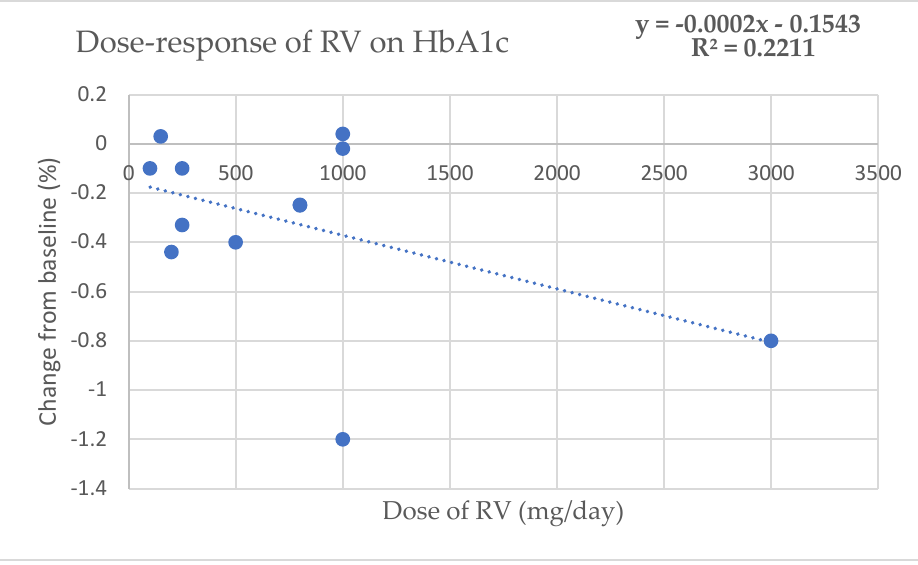
Figure A2. Dose–response regression analysis to assess the effect of RV on HbA1c.